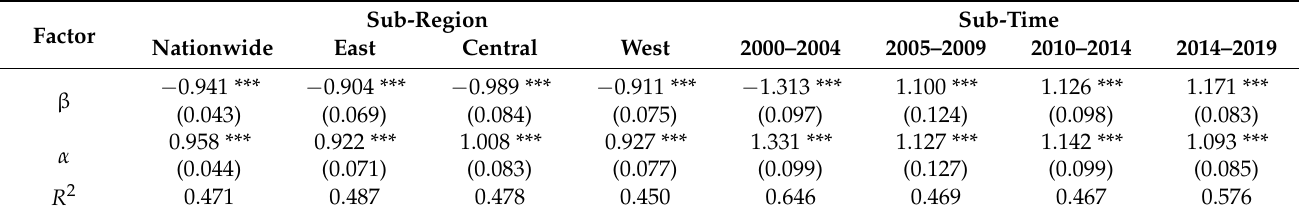
Table 5. Absolute β convergence results for AGTFP.